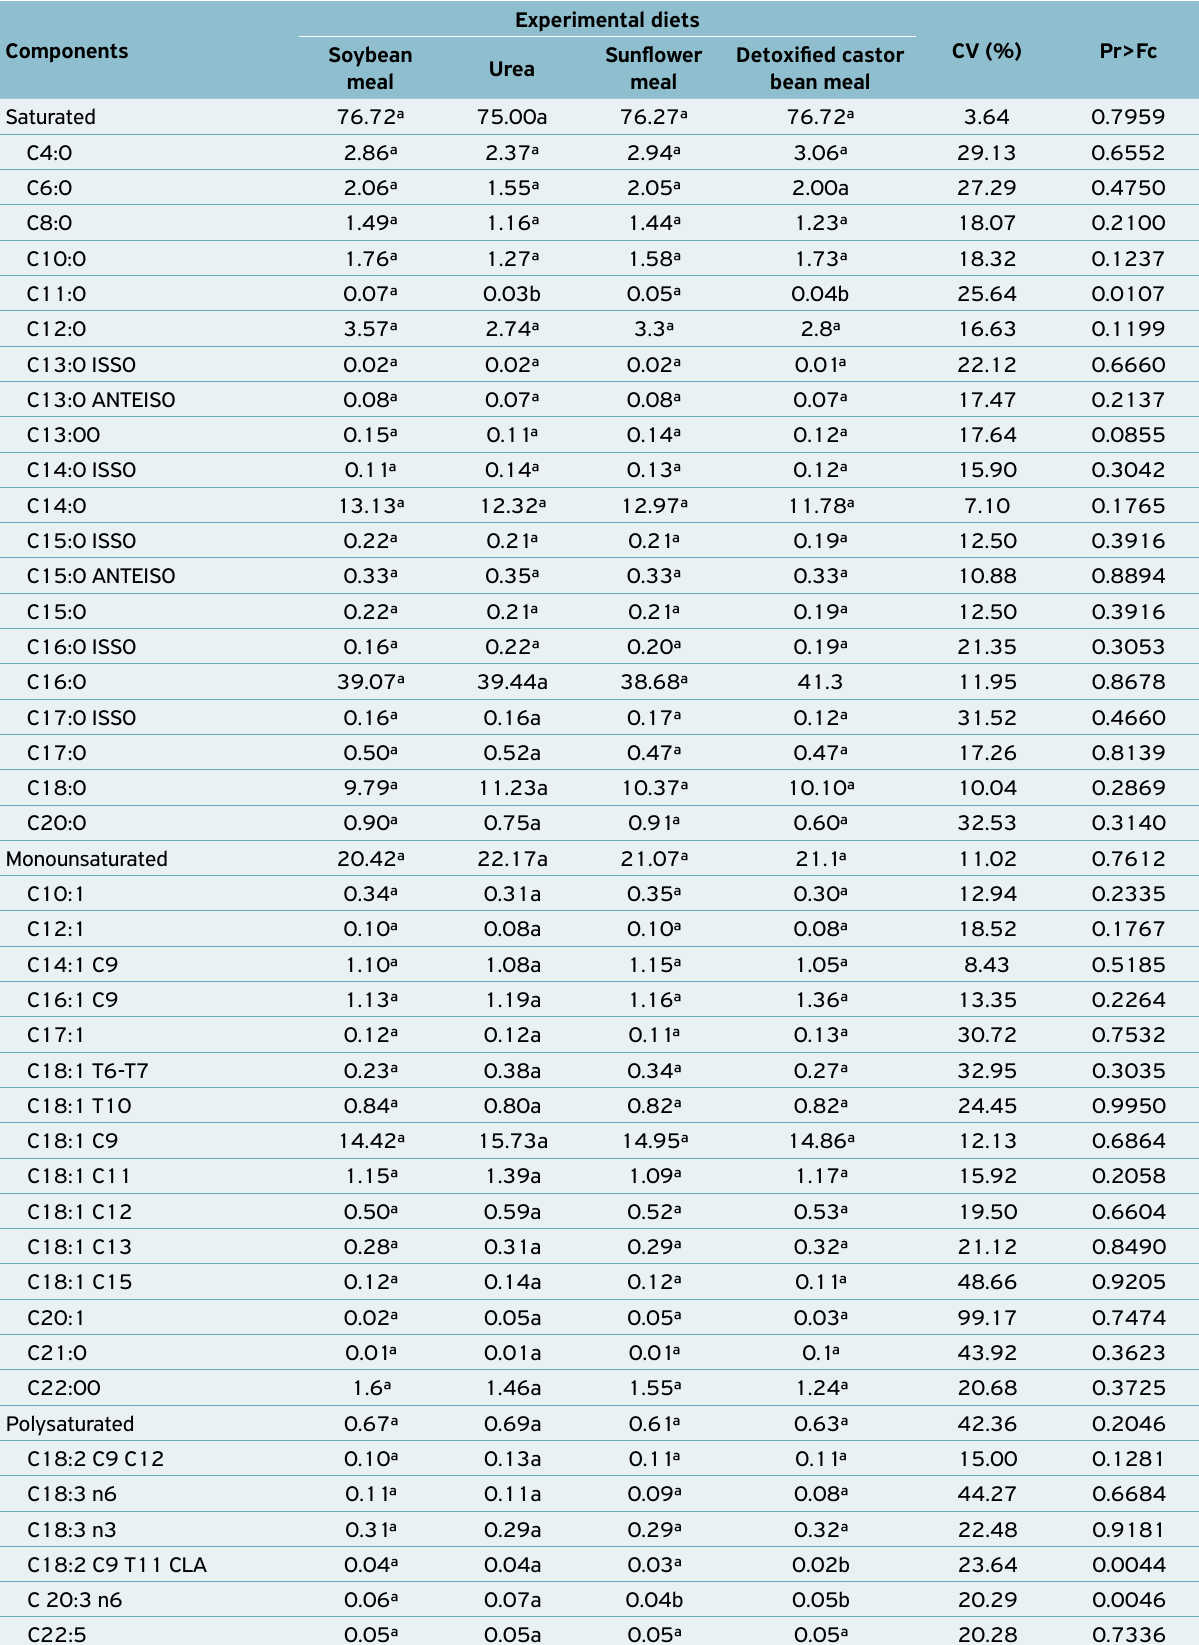
Table 4. Fatty acid profile of the fat of Minas fresh cheese (mg/g fat) made with milk from F1 Holstein/Zebu cows fed diets containing different sources of nitrogen